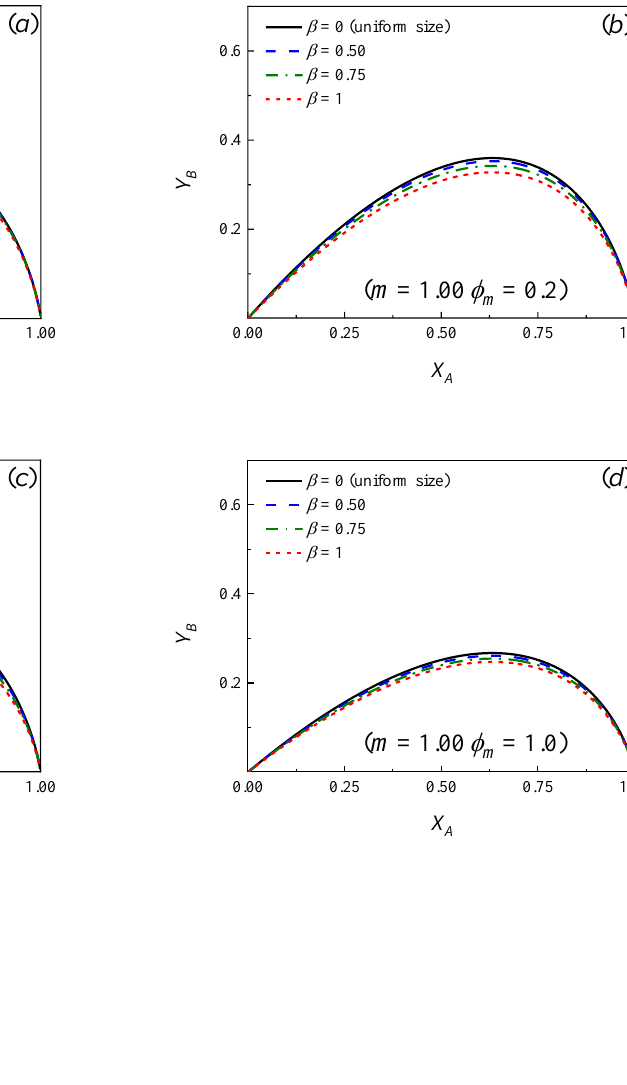
Figure 2. Yield of primary product B as a function of the conversion of the reactant A for different values of the dispersion parameter ( β ). m = k 2 / k 1 = 0.25. ( a ) ϕ m = 0.1; ( b ) ϕ m = 0.2; ( c ) ϕ m = 0.3; ( d ) ϕ m = 1.0; ( e ) ϕ m = 2.0; ( f ) ϕ m = 3.0.